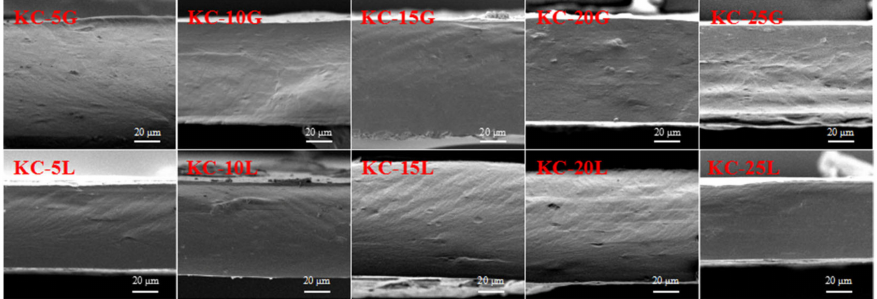
Figure 2. SEM images of carrageenan film containing GG and